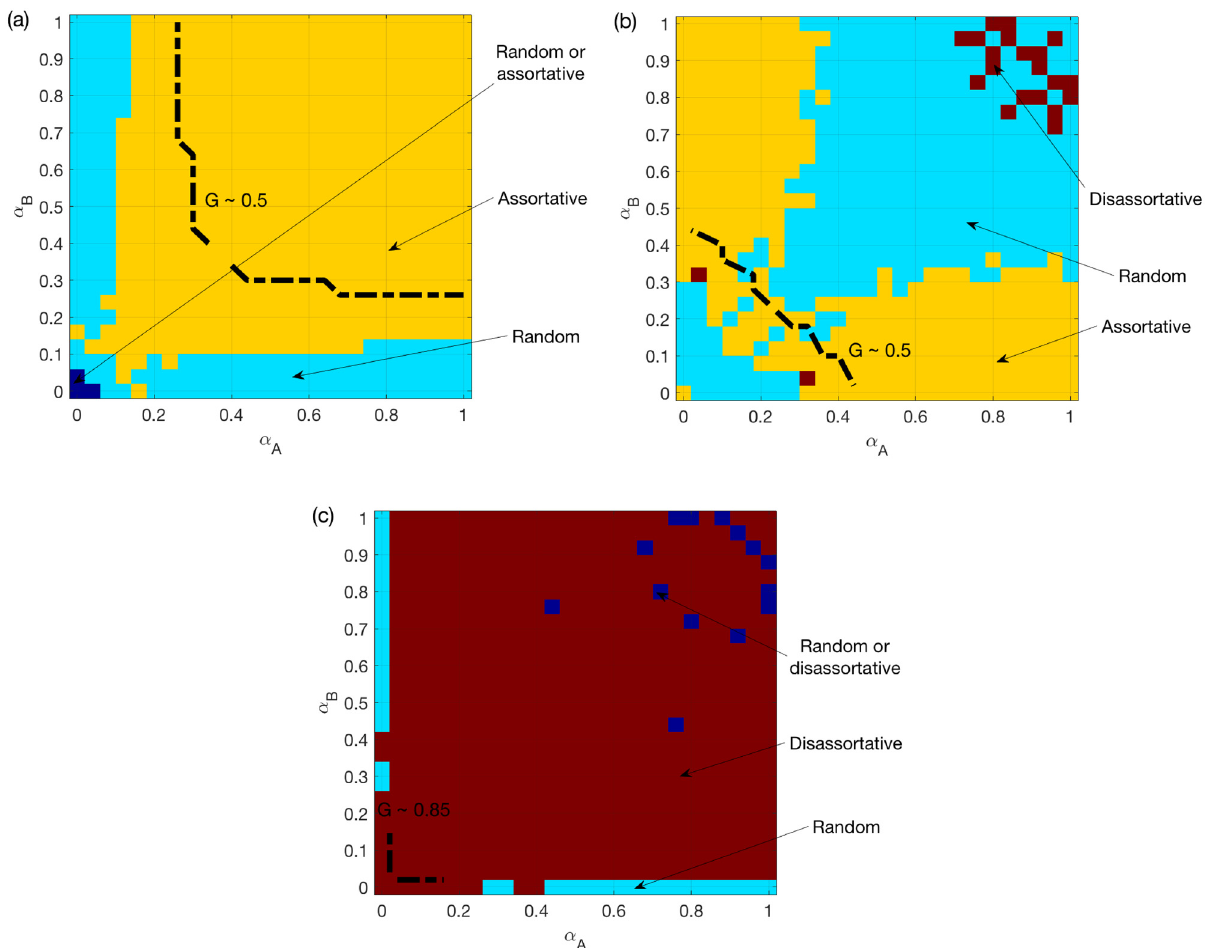
Fig 3. Best choice among random/assortative/disassortativecoupling schemes for two SF networks. (a) OR rule. (b) SUM rule. (c) AND rule. N = 500, k A = k B = 6, averagedover M = 50 realizations. The color for certain α A and α B values indicatesthe couplingscheme with the largest mean G value. A dashedline is added to each sub-figureto indicate the location where the best mean G reaches0.5, or 0.85 for (c).